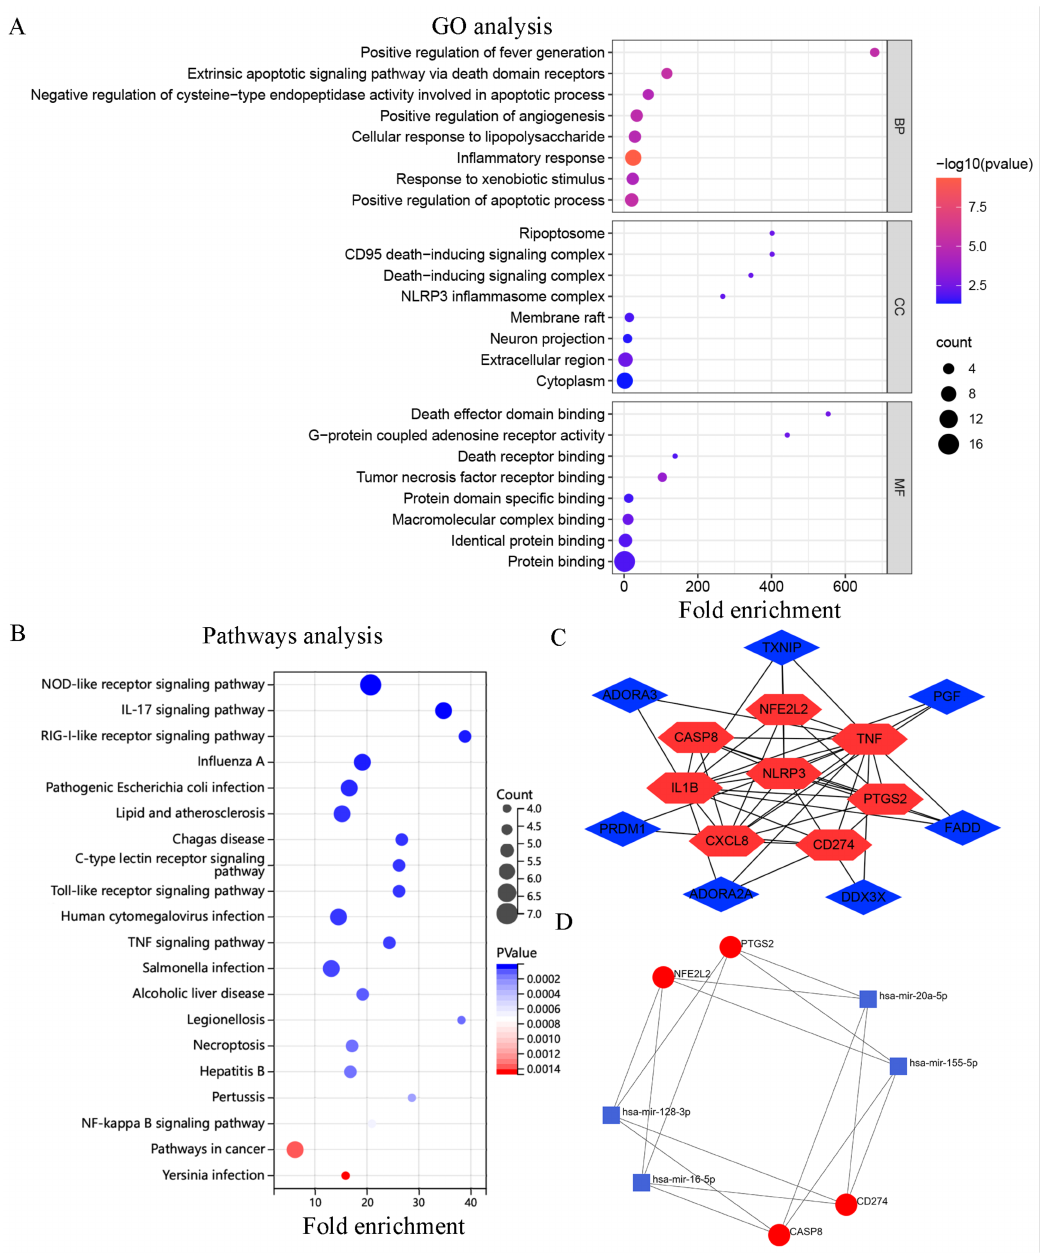
Figure 2. Enrichment analysis, PPI network, and miRNA-mRNA network of DEGs. ( A ) Top 8 GO terms; ( B ) Top 20 KEGG pathways; ( C ) PPI networks and hub genes; ( D ) MiRNA-mRNA